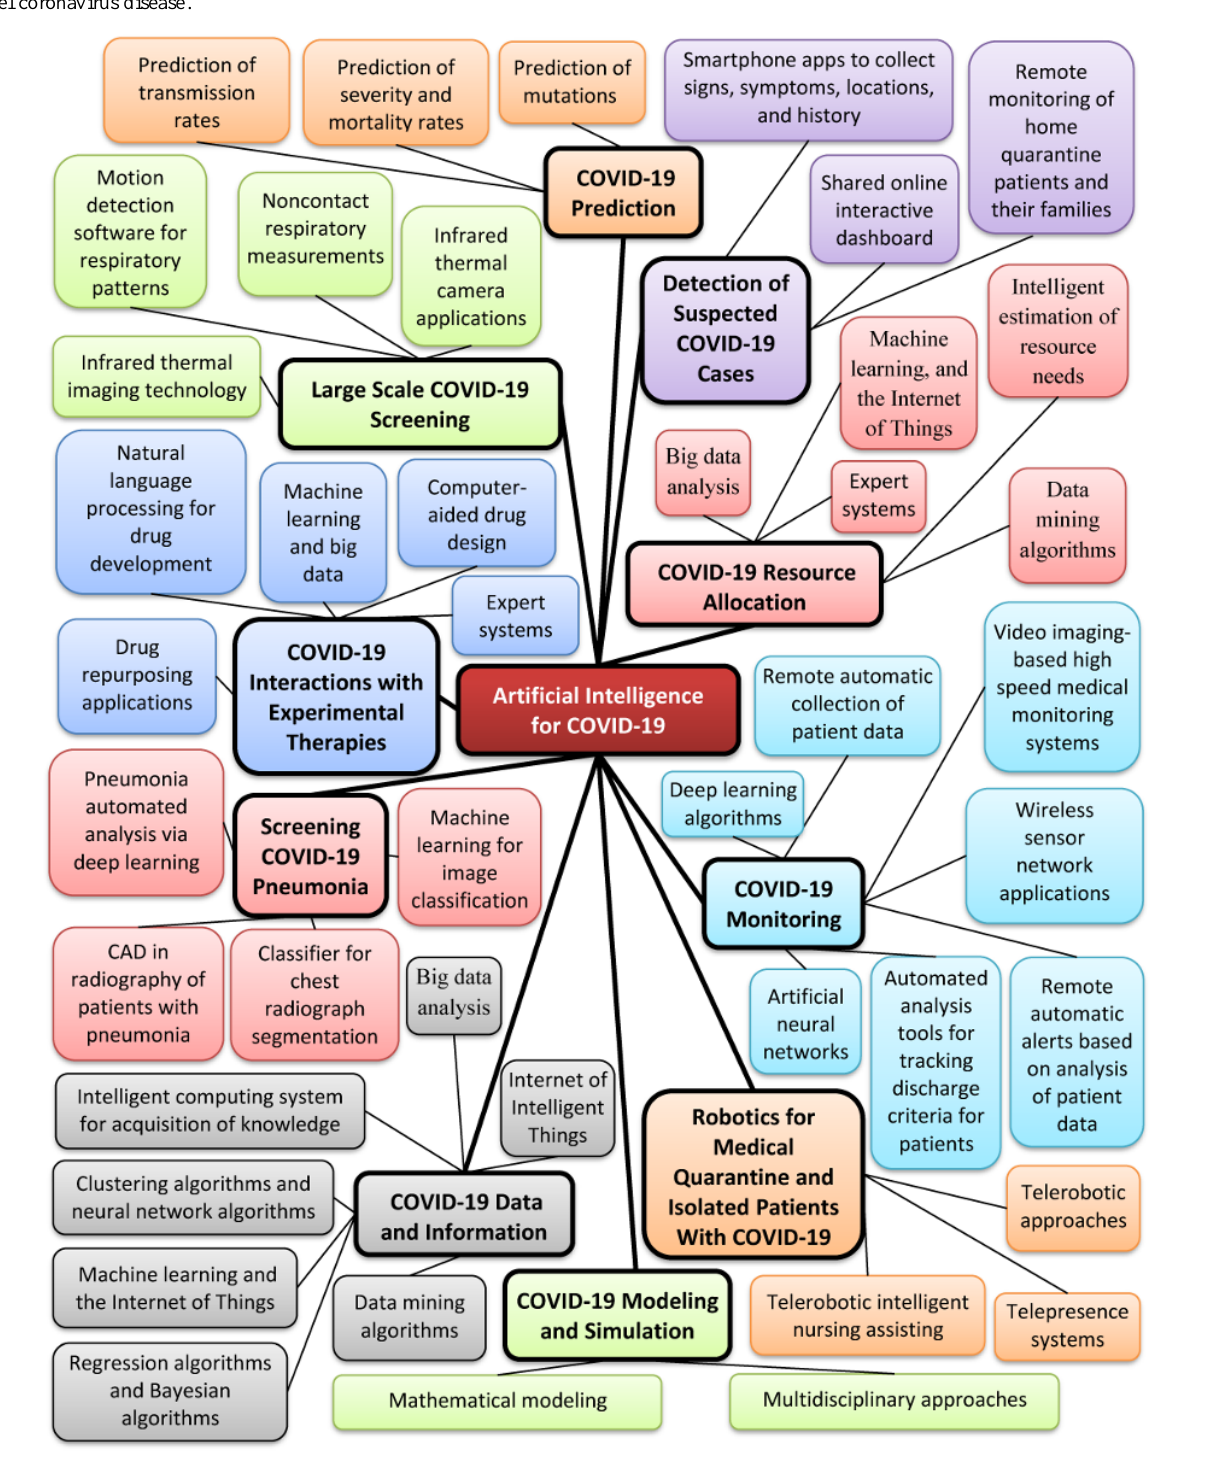
Figure 1. Summary of AI approaches to address the COVID-19 pandemic. AI: artificial intelligence; CAD: computer-aided diagnosis; COVID-19: novel coronavirus